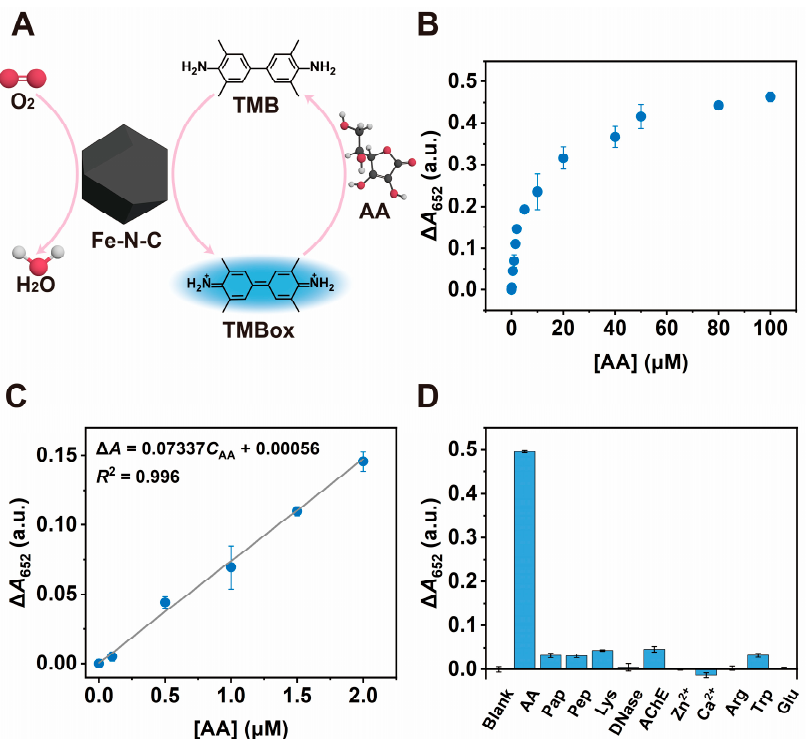
Figure 4. Colorimetric detection of AA based on reduction activity. ( A ) Schematic illustration of the AA-sensing principle. ( B ) Relationship between the relative absorbance at 652 nm ( Δ A 652 ) and the concentration of AA. ( C ) Linear calibration plot for AA detection. ( D ) Selectivity test. Concentrations of the interferents: 100 µM AA, 25 mM Zn 2+ and Ca 2+ , and 10 mM Arg, Try, and Glu, 2.5 U mL − 1 Pap, Pep, Lys, DNase, and AChE.